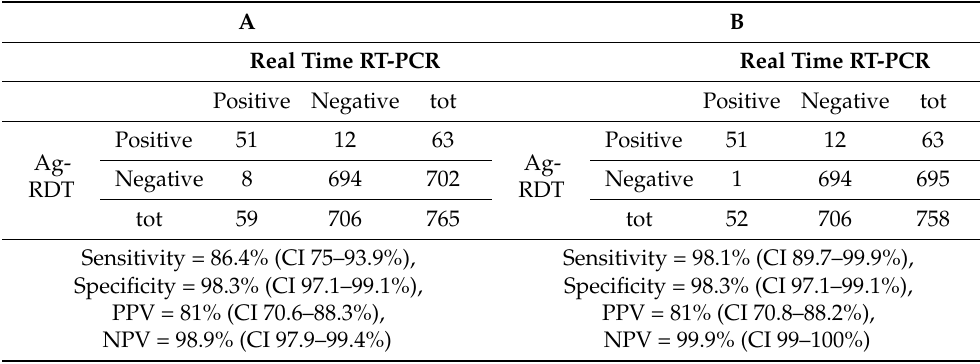
Table 4. Cross-table, sensitivity, specificity, positive predictive value (PPV), negative predictive value (NPV) for AFIAS COVID-19 Ag-RDT.